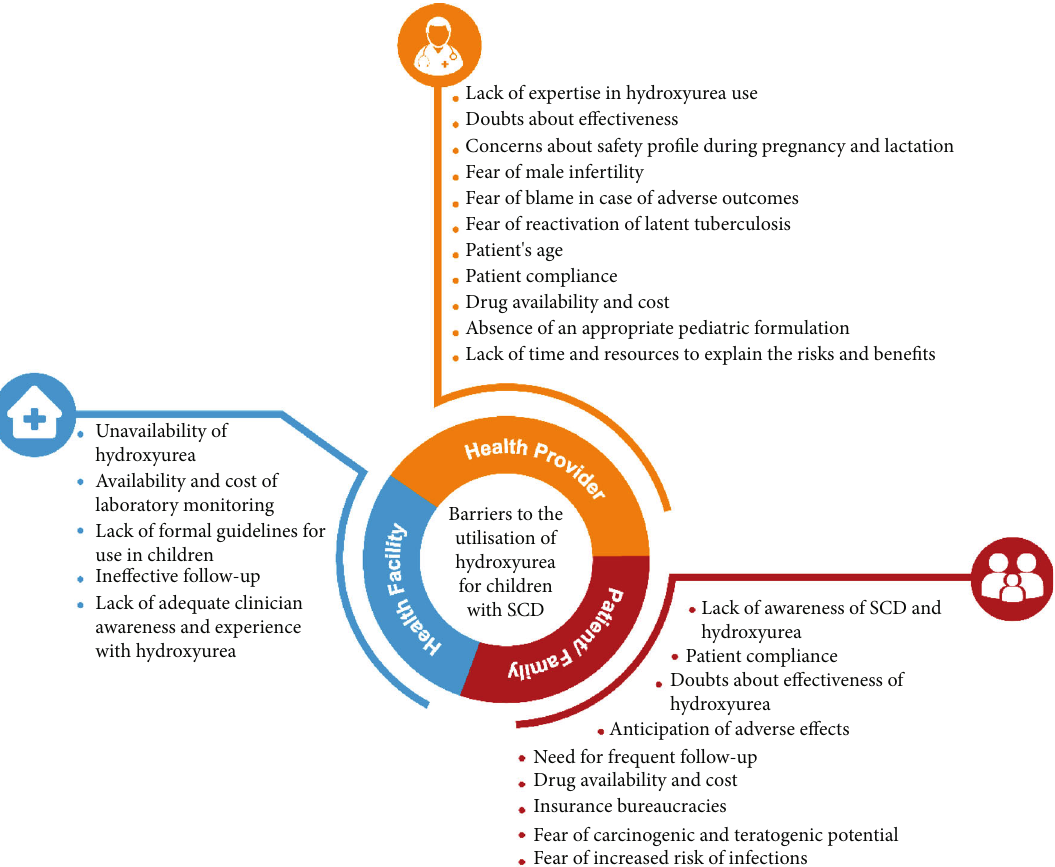
Figure 3: Barriers to utilization of hydroxyurea for children with